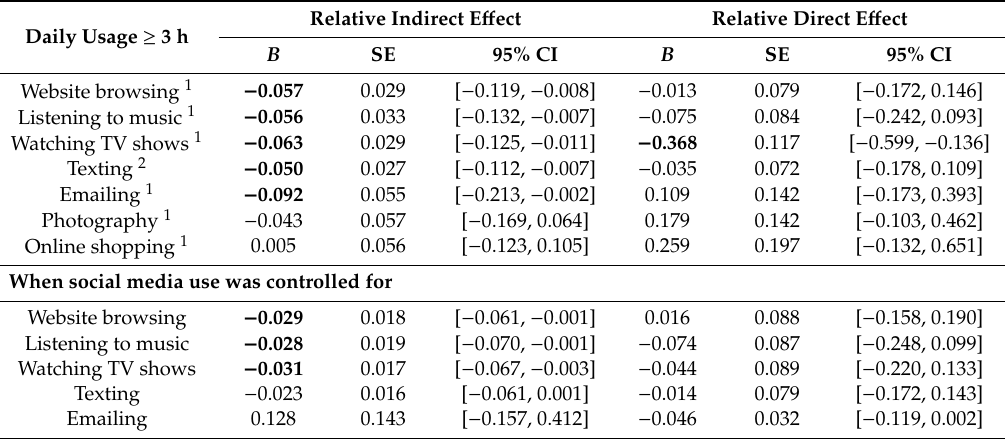
Table 2. Results of Serial Mediation Analyses for Screen Time for Smartphone Activities and Body Esteem via Cognitive Internalization, Appearance Comparison, and Social Appearance